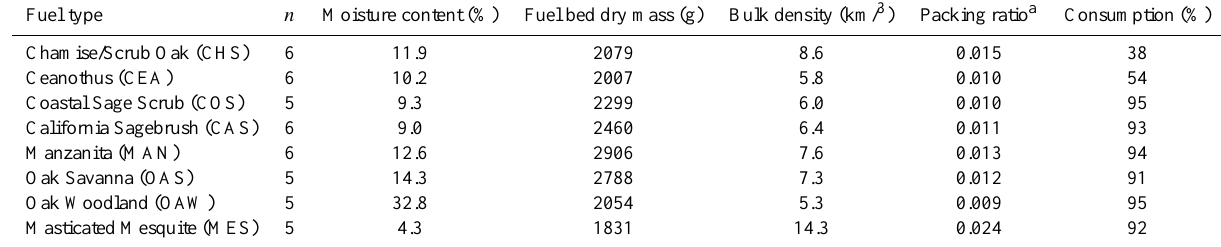
Table 2. Fuel and bed